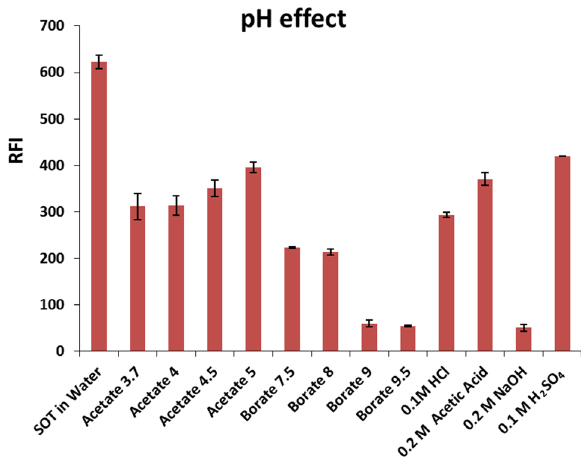
Figure 3: Effect of pH (0.2 M acetate buffer, 0.2 M Borate buffer, 0.1 M H SO , 0.1 M NaOH and 0.1 M HCl) on the RFI of SOT (180.0 ng/mL) 2 4 and